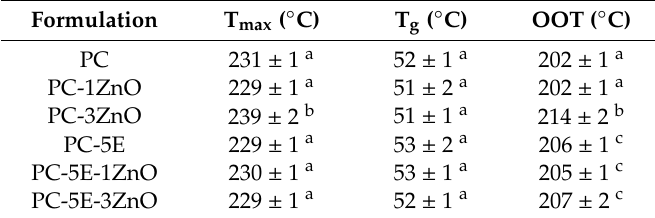
Table 2. Thermal properties of pectin-based films.